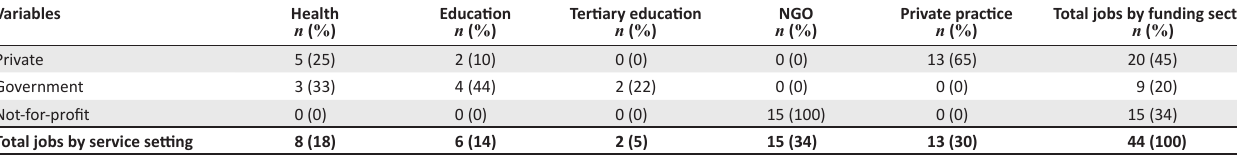
TABLE 1: Speech and language therapy jobs by funding sector and employment setting.